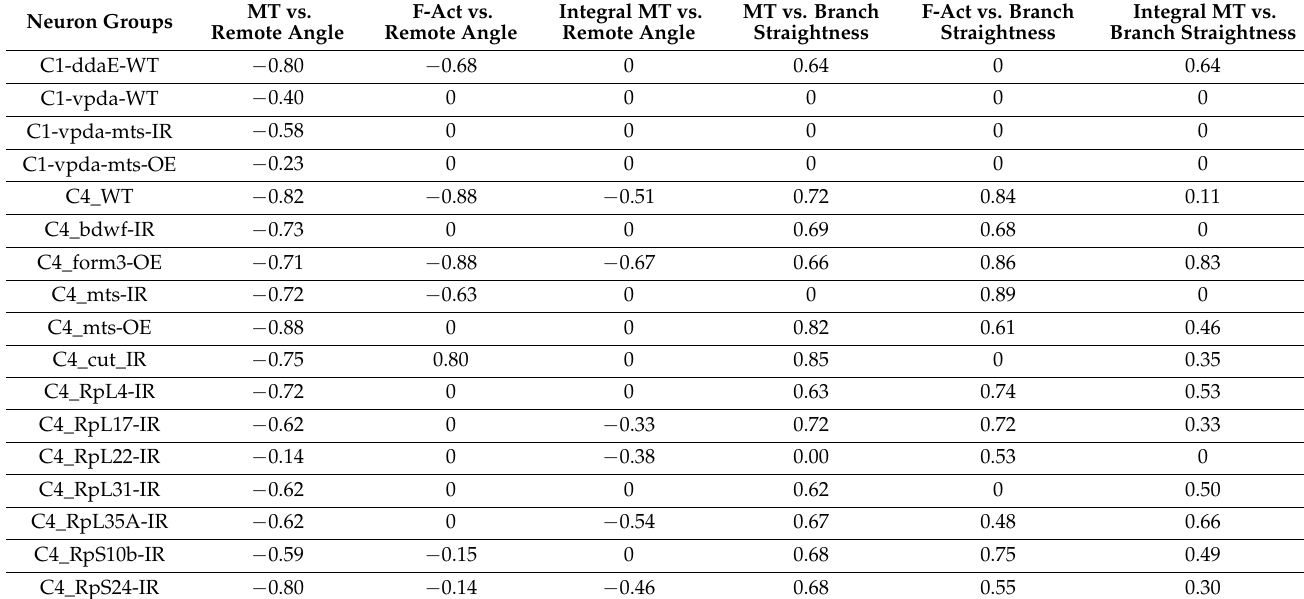
Table 2. Pearson’s correlations between average branch MT, F-actin or integral MT and remote branch angle or branch straightness for all 17 neuron groups. Values not reaching statistical significance after False Discovery Rate correction for multiple testing were substituted with 0